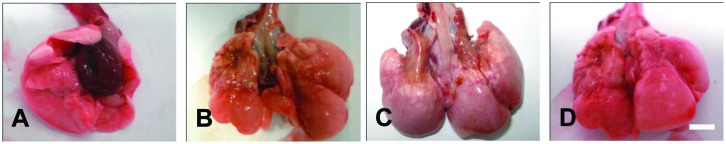
Effect of epigallocatechin-3-gallate (EGCG) on the lung appearance at 120 days post gamma-ray irradiation. (A) Hematoxylin and eosin (H&E) staining of lung tissue from non-irradiated normal control, (B) untreated irradiated, but (C) dexamethasone (DEX)-treated irradiated and (D) EGCG-treated irradiated rats. Untreated irradiated and DEX-treated irradiated animals show marked lung collapse, rough surfaces and gray fibrous nodule development. EGCG treatment animals show lung tissue edema, rough surfaces, scattered punctate bleeding, but no lung collapse and gray fibrous nodules. Bar, 0.5 cm.